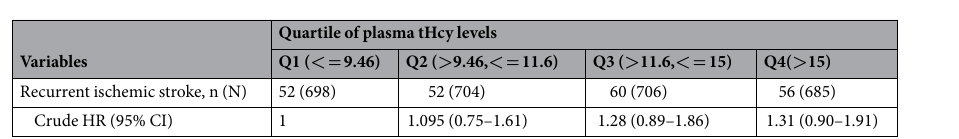
Table 4. Association of tHcy levels by quartile within three days of acute stroke with recurrent ischemic stroke ( μ mol/L). CI, confidence interval; HR, hazard ratio; tHcy, total homocysteine.